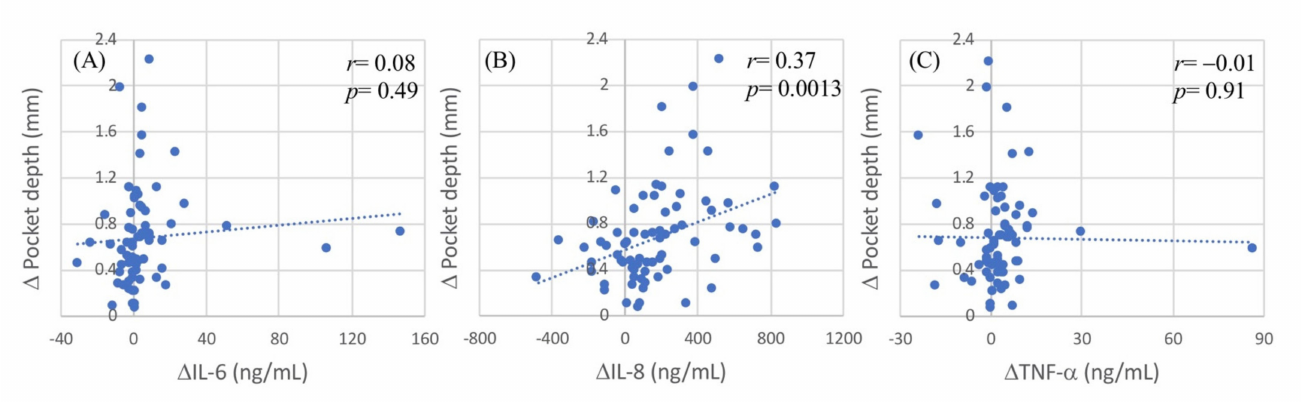
Figure 2. Scatter plot of difference ( ∆ ) in IL-8 and ( ∆ ) in clinical indices. ( A ) Difference ( ∆ ) in salivary interleukin-8 (ng/mL) and difference ( ∆ ) in plaque index (%). ( B ) Difference ( ∆ ) in salivary interleukin-8 (ng/mL) and difference ( ∆ ) in bleeding on probing (%). ( C ) Difference ( ∆ ) in salivary interleukin-8 (ng/mL) and difference ( ∆ ) in pocket depth (mm). ∆ IL-8 = baseline IL-8–after treatment IL-8; ∆ plaque index = baseline plaque index–after treatment plaque index. ∆ Pocket depth = baseline pocket depth–after treatment pocket depth.